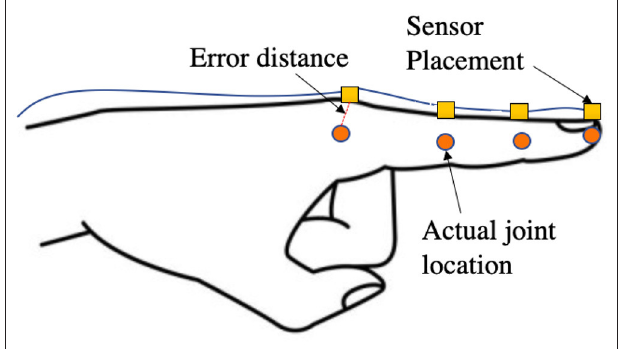
FIGURE 8 | Illustration to show the error in the true position of the hand when measuring using a sensor placed on top of the finger. There is a small gap since the sensor placement is superficial, and the true position of joints that lie inside the hand will have large errors.